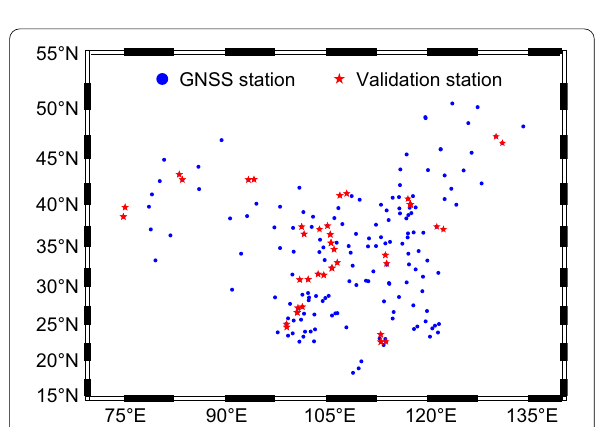
Fig. 3 Distribution of GNSS stations and validation stations for a regional